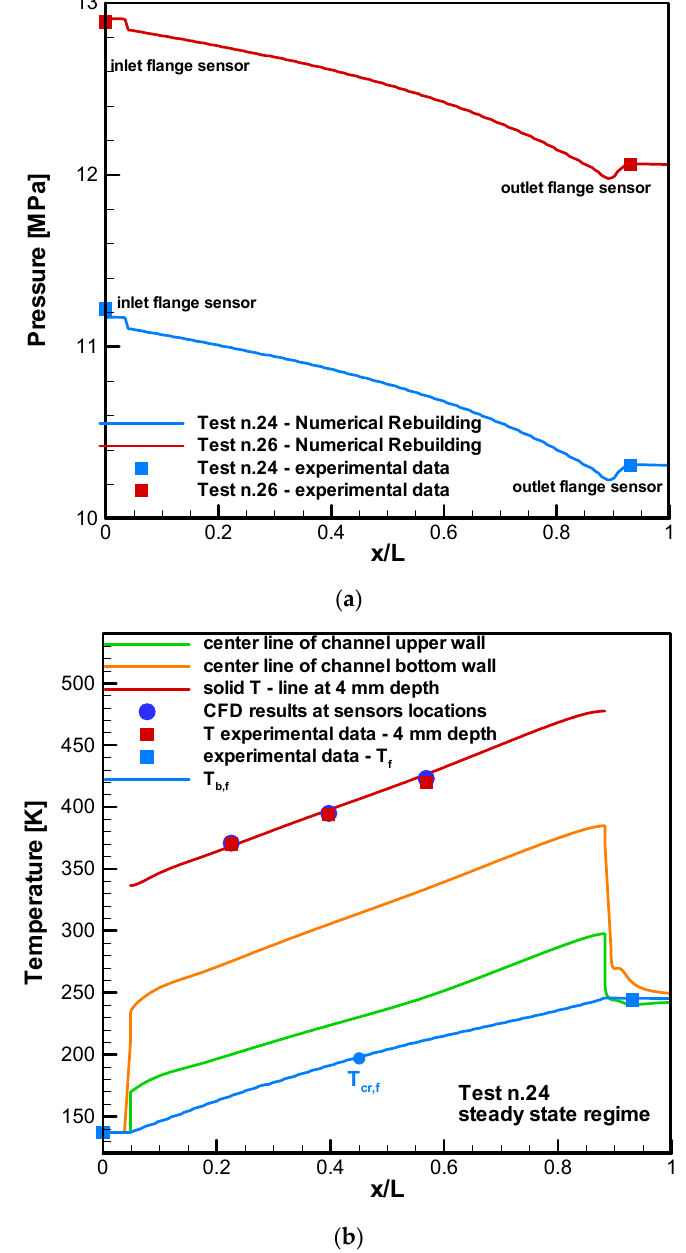
Figure 11. MTP breadboard rebuilding of hot tests: ( a ) Pressure drops (test #24 and #26); and ( b ) Fluid temperature and bottom wall temperature profiles (test 24).